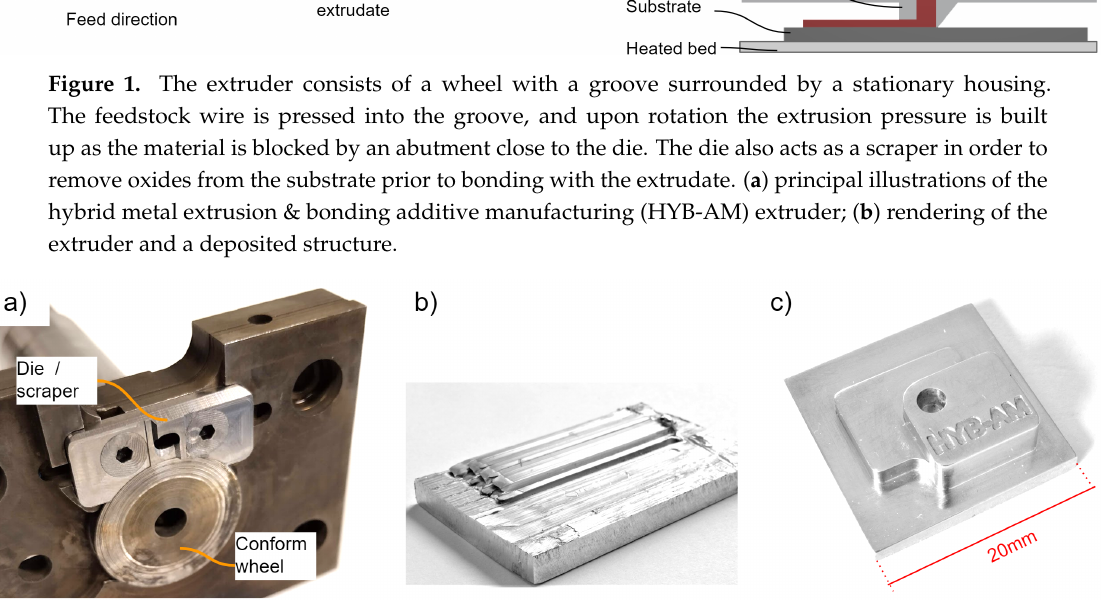
Figure 2. Full-scale demonstration of the HYB-AM process. ( a ) the extruder prototype; ( b ) two layers (4 + 3 stringers) of AA6082 deposited on a substrate of the same alloy; ( c ) net-shape demo sample after post-processing by subtractive